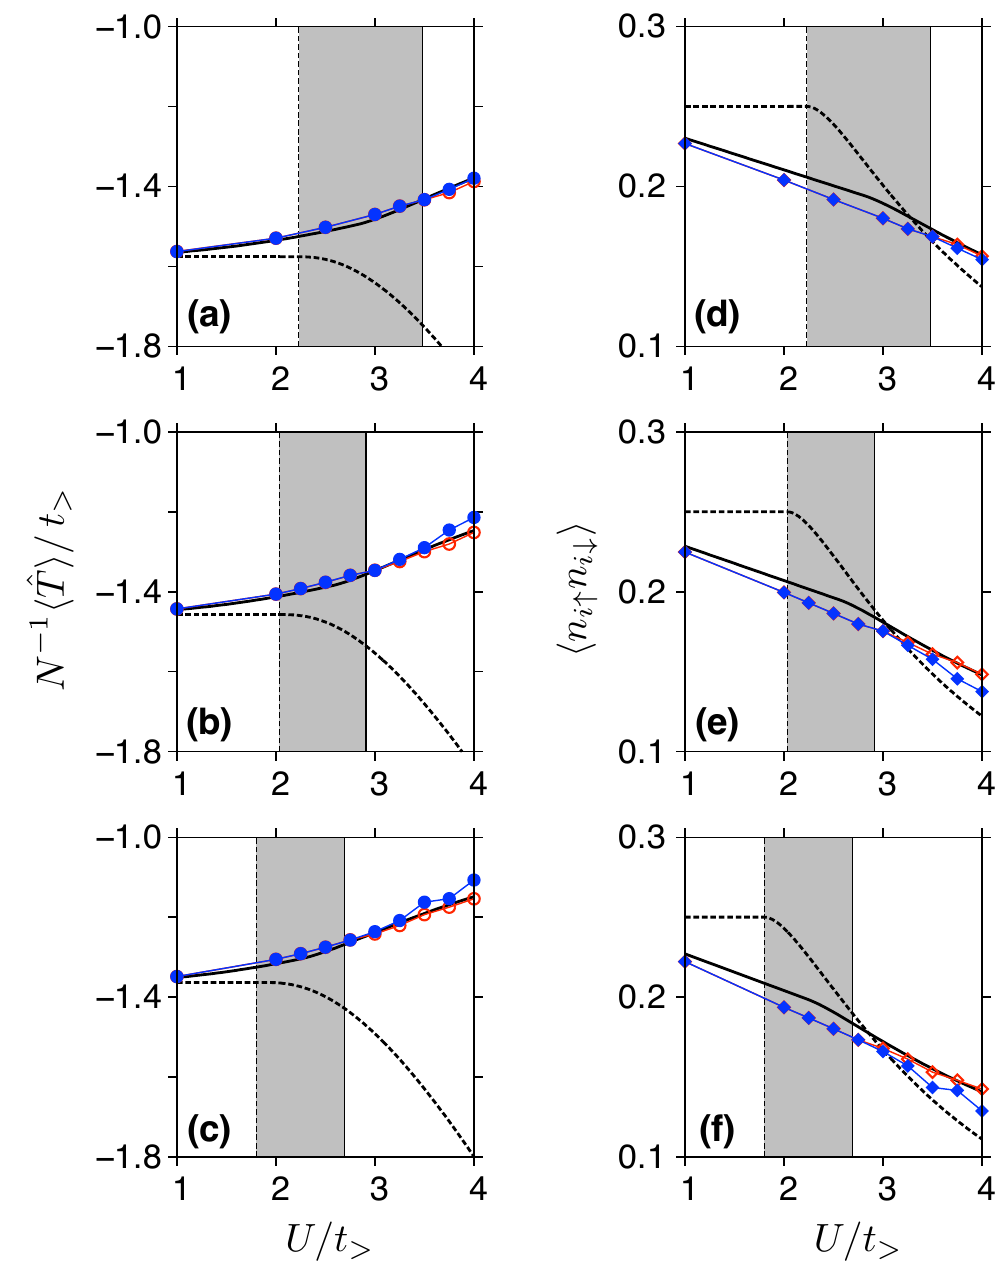
Figure 7. ( a – c ) Average kinetic energy per site and ( d – f ) average double occupancy displayed as functions of the Hubbard repulsion U for t y / t x = 1 (top), t y / t x = 0.75 (middle), and t y / t x = 0.5 (bottom). Thick dashed line marks the Hartree–Fock results, thick solid line represents the Gutzwiller Approximation. Datapoints depict the VMC results for GWF with m = 0 (red open symbols) and optimized m (blue closed symbols); thin lines are guide for the eye only. Shaded area marks the correlated semimetallic phase, bounded by U ( HF ) c and U ( GWF ) c . (For the numerical values, see Table